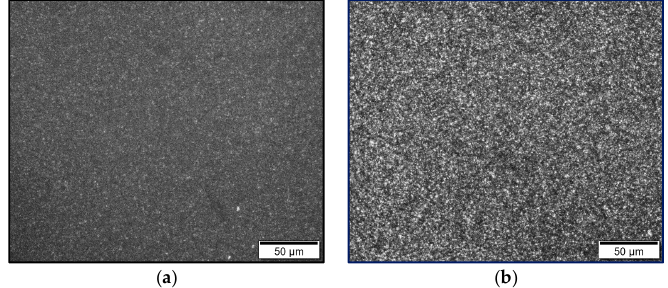
Figure 7. Optical microscopy (OM) images of extruded films ME-0 ( a ) before thermal treatment and ( b ) after thermal treatment.